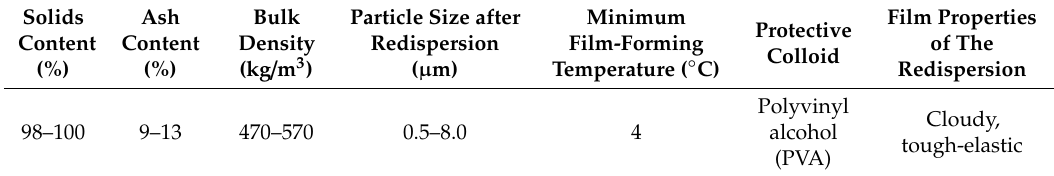
Table 3. Properties of EVA powder.